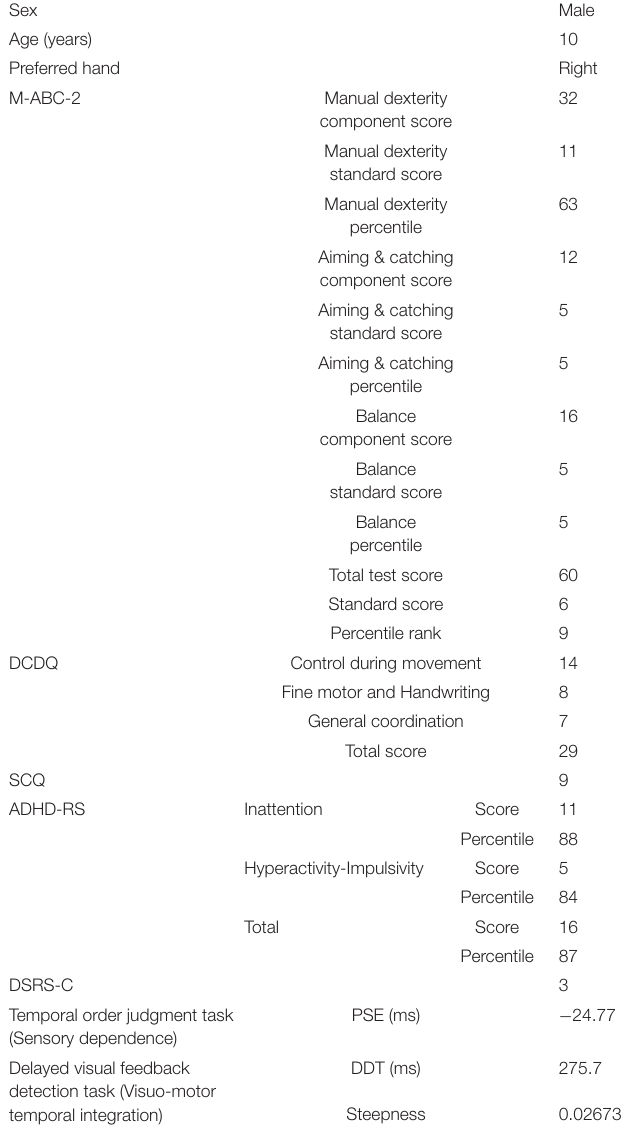
TABLE 1 | Results of tests conducted on the day before the current study. Sex Male Age (years) 10 Preferred hand Right